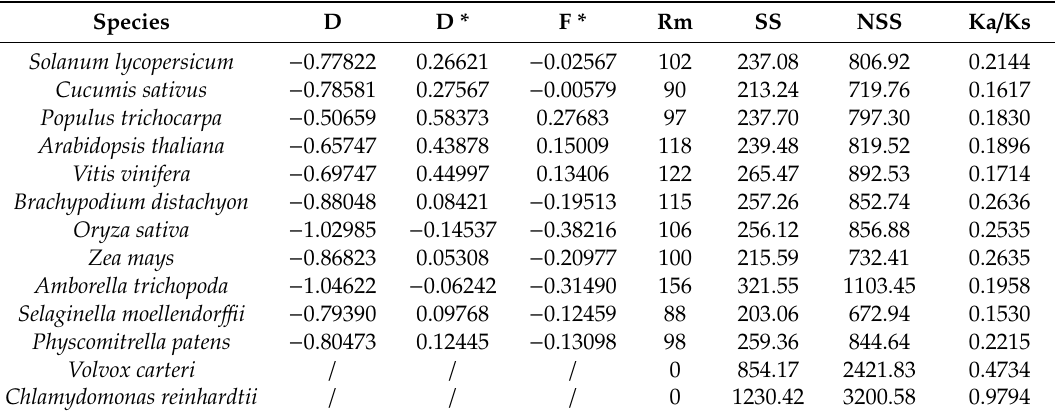
Table 4. Neutral testing and base substitution of MLO genes in di ff erent